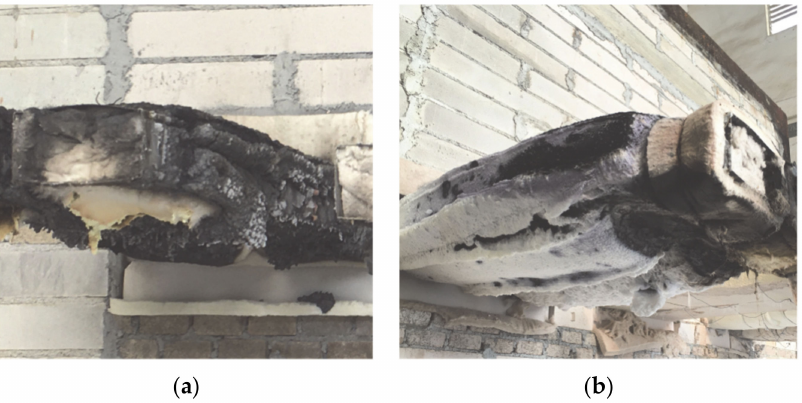
Figure 11. Appearance of specimens after fire test: ( a ) specimen of case 2; ( b ) specimen of case